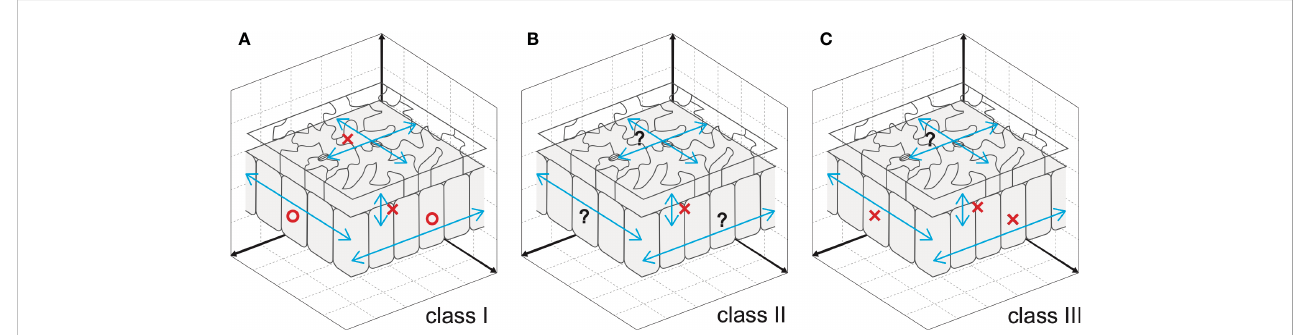
FIGURE 1 Cellular spatial relationships during induction of CCE. (A) Mesophyll cells exploit cell-to-cell communication to stimulate CCE in response to de fi cient cell proliferation in an3 , which has class I compensation (Kawade et al., 2010). By contrast, epidermal cells trigger CCE in a cell-autonomous manner, preventing cell-to-cell communication across tissue layers (Nozaki et al., 2020). (B) Cell-to-cell communication between epidermal and mesophyll cells is absent in fugu5 , which has class II compensation (Gunji et al., 2022). Given that excess PPi inhibits metabolic reactions, fugu5 -mediated induction of CCE is likely controlled in a cell-autonomous manner. (C) Direct inhibition of cell cycle progression by KRP overexpression, a representative of class III compensation, induces CCE in a cell- and tissue-autonomous manner. This was determined using chimeric KRP2-overexpressing leaves generated using the Cre/ lox -P system (Kawade et al., 2010) and KRP1-overexpressing leaves with a tissue-speci fi c expression system (Bemis and Torii, 2007). Epidermal cell-to-cell communication remains to be explored. Circles and crosses indicate, respectively, the presence and absence of cell-to-cell communication that stimulates CCE. Question marks are added when cell-to-cell communication is still